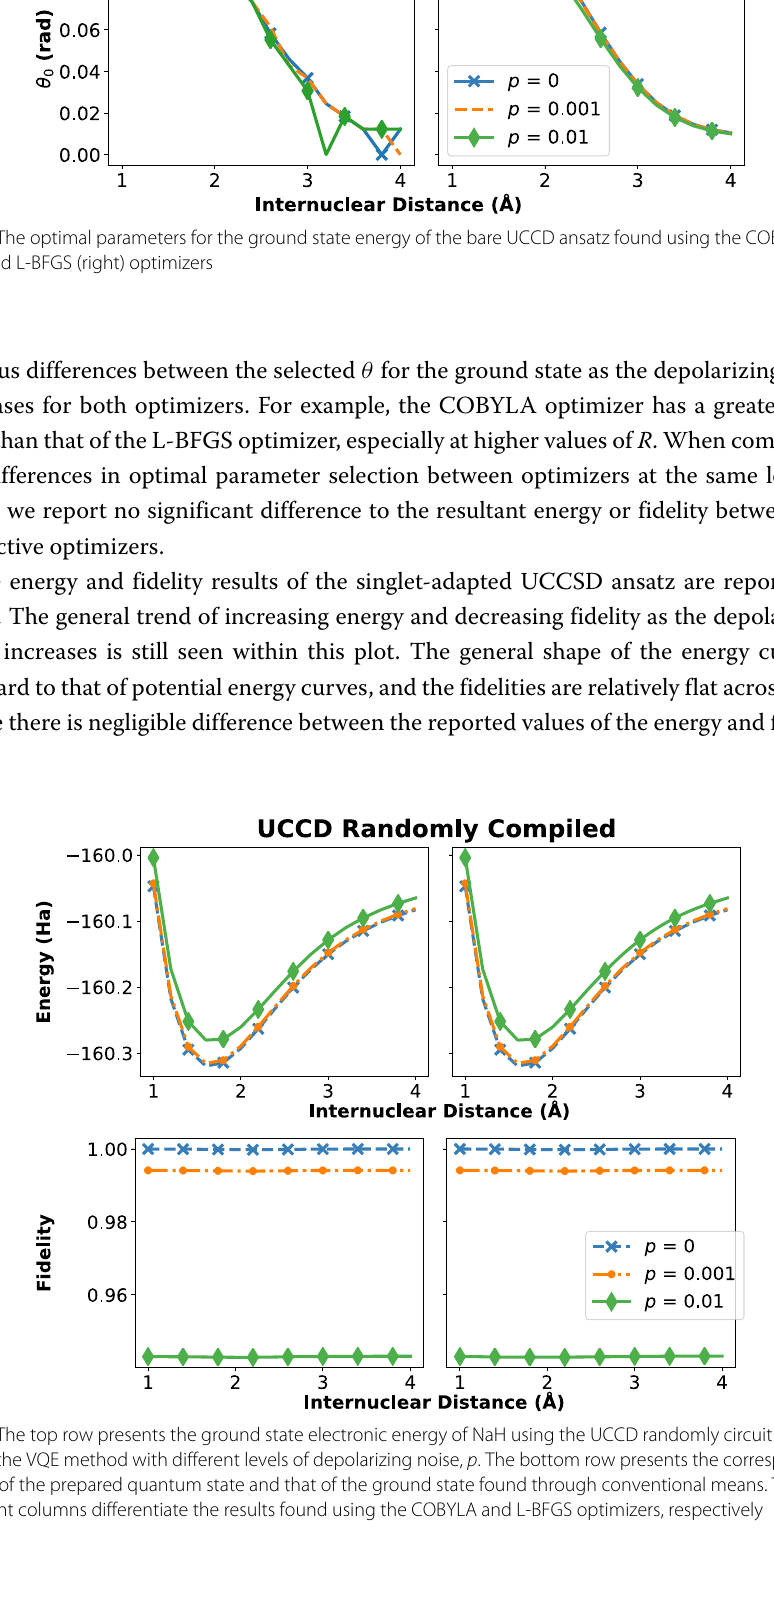
Fig. 4 The top row presents the ground state electronic energy of NaH using the UCCD randomly circuit ansatz within the VQE method with different levels of depolarizing noise, p . The bottom row presents the corresponding fidelity of the prepared quantum state and that of the ground state found through conventional means. The left and right columns differentiate the results found using the COBYLA and L-BFGS optimizers,